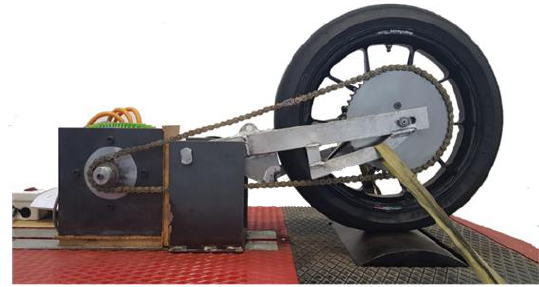
Figure 1. Rear drivetrain setup in the test bench.